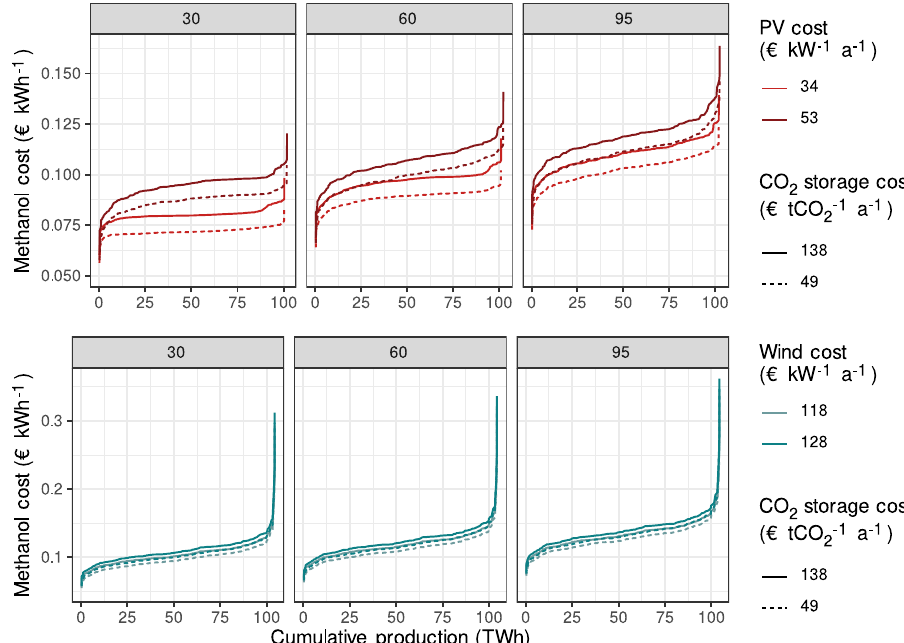
Fig. 3 Cost – supply curves for selected scenarios and cost assumptions. The cost assumptions are annualized. Upper: solar – wind scenario. Lower: wind scenario. From left to right: annualized electrolyzer cost assumptions ( € kW − 1 a − 1 ). We assume here an electrolyzer ef fi ciency of 69%, an annualized battery storage cost of 33 € kWh − 1 , and an annualized H 2 storage cost of 74,300 € t − 1 . PV